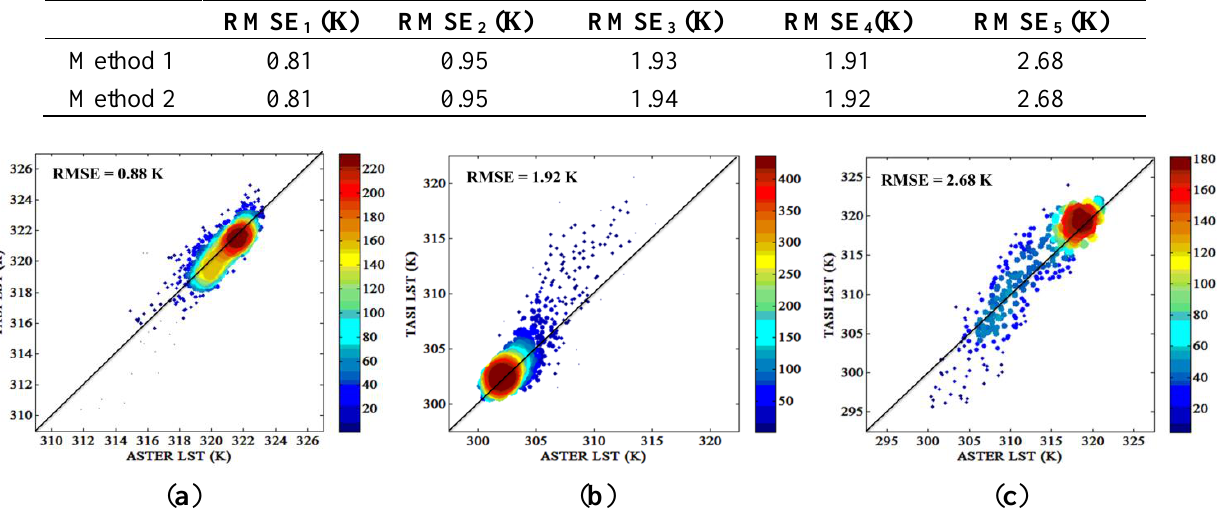
Figure 8. Comparison between the ASTER LST data and the TASI LST data in ( a ) Gobi areas; ( b ) cropland areas and ( c ) the mixed area. The TASI LSTs were upscaled using Method 1. The sizes of the dots in the scatterplots correspond to their density in the swarm of points. The larger dots are given hotter colors in the dense particle